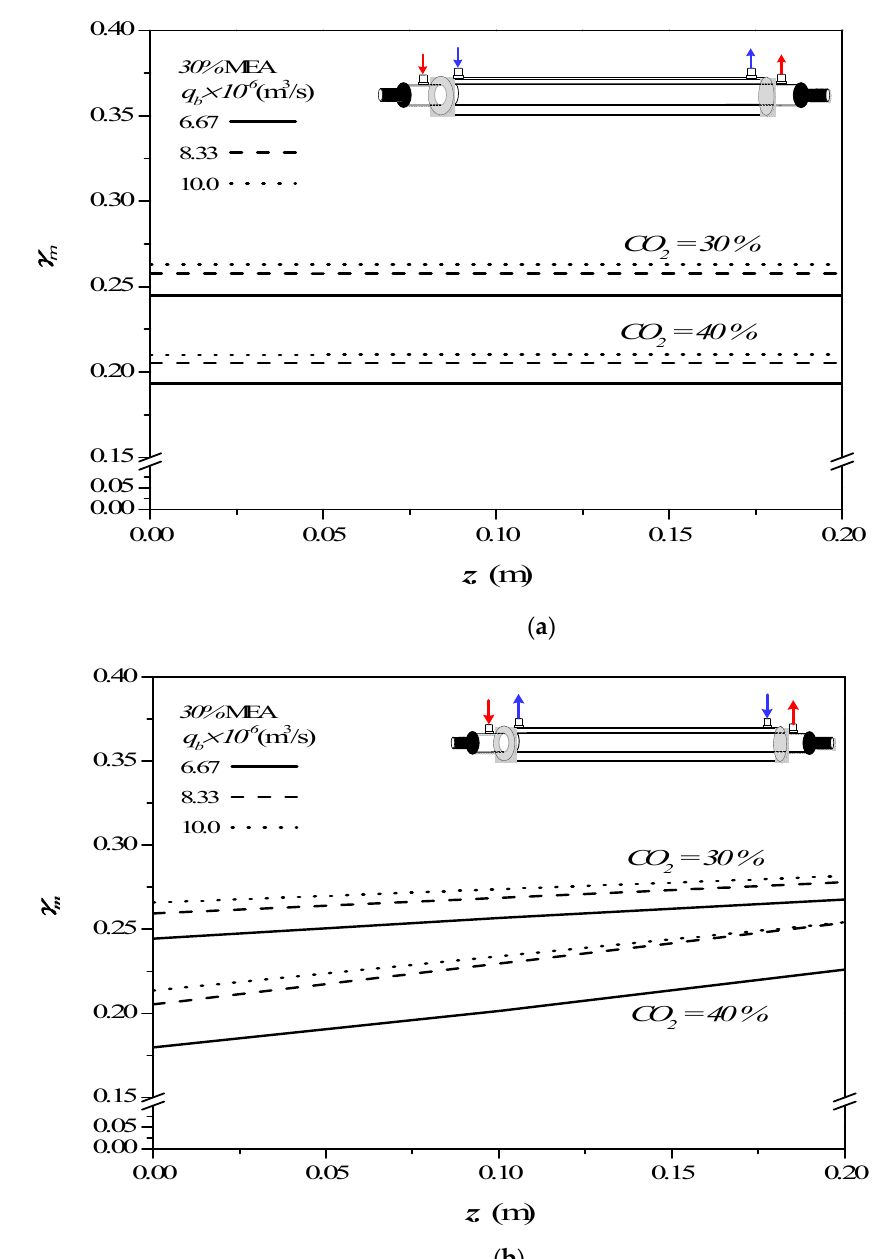
Figure 8. Effects of MEA flow rate and inlet feed CO 2 concentration on m γ in the empty channel.